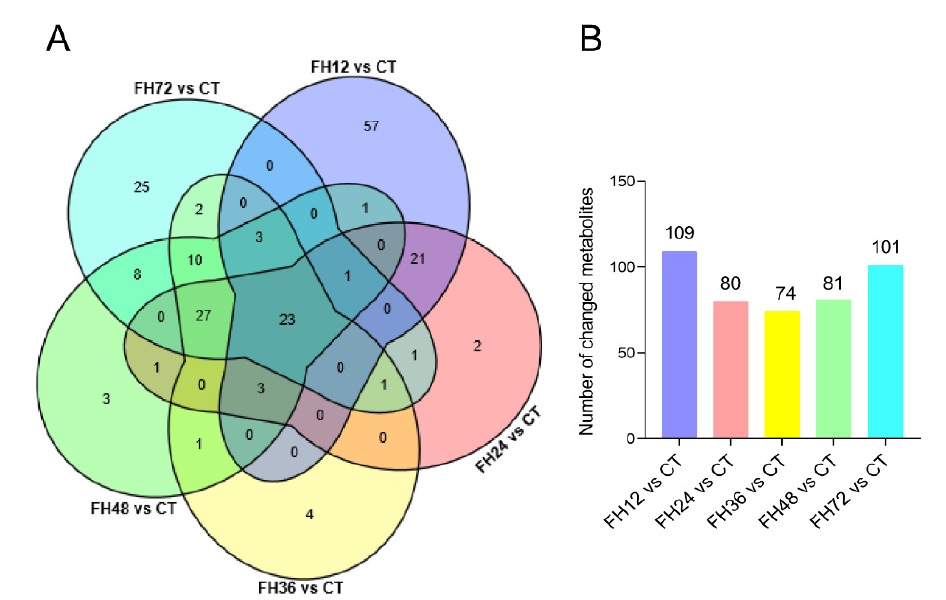
Figure 4. ( A ) Venn diagram of the changed metabolites for different treatments and ( B ) the changed metabolite numbers during different fasting durations when compared with the non-fasting group.